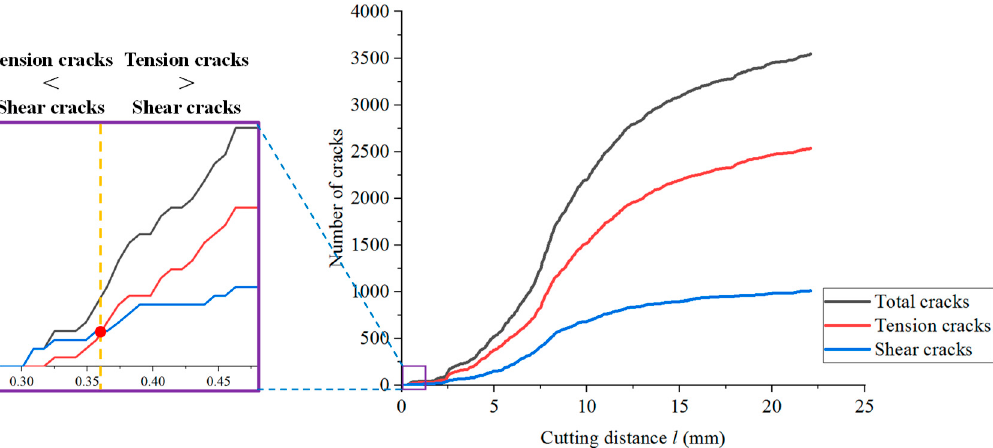
Figure 23. Variation characteristics of the number of cracks in the sample with a bedding angle of 60°.